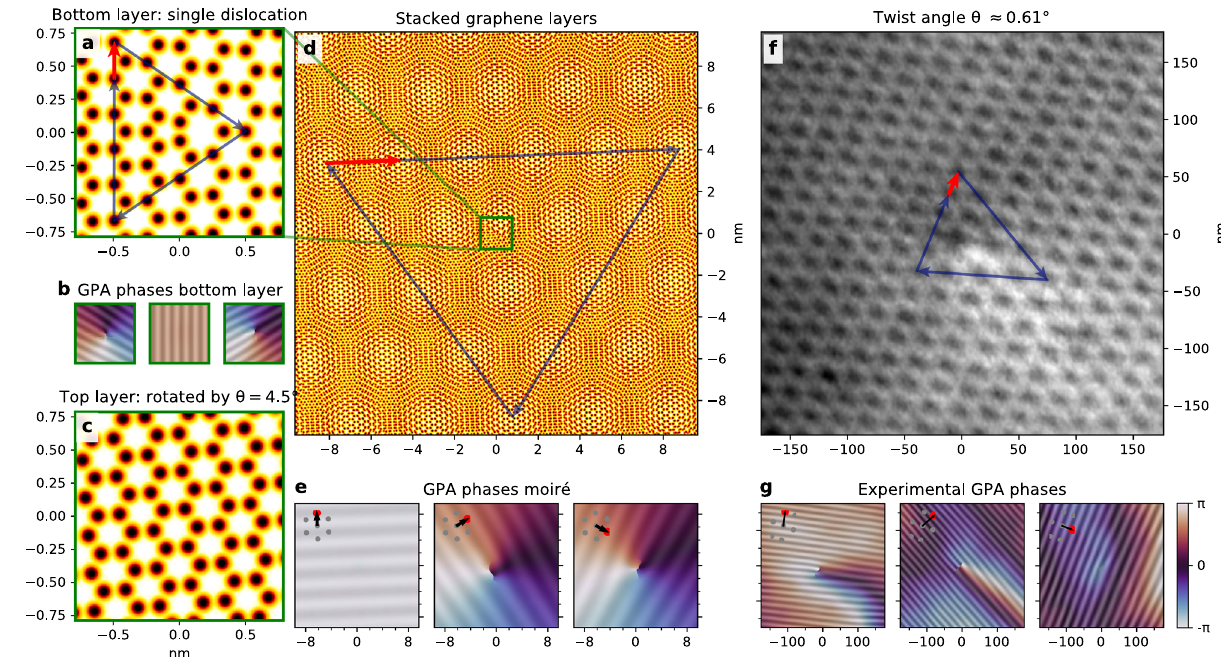
Fig. 3 Edge dislocations in moiré systems. a Schematic of an edge dislocation in single-layer graphene (centered in the fi eld-of-view), with the corresponding Burgers vector analysis (blue arrows, Burgers vector indicated in red). b GPA phases of ( a ). c Top layer without dislocation, rotated 4.5 ∘ with respect to the layer in ( a ). d Schematic of an edge dislocation of single-layer graphene in a twisted bilayer system. The green square in the center corresponds to the combination of ( a ) and ( c ). The Burgers vector analysis of the moiré lattice defect is indicated by blue arrows, the resulting Burgers vector in red. Note: Both the schematics in ( a ) and ( d ) are mathematical representations of the dislocation, i.e., without taking atomic relaxation into account. e GPA phases of d , exhibiting a singularity in the center. The used moiré reference vectors are indicated. f LEEM image of an edge dislocation in a TBG moiré lattice with a twist angle θ ≈ 0.63°. The corresponding moiré Burgers vector is indicated in red. g GPA phases corresponding to ( f